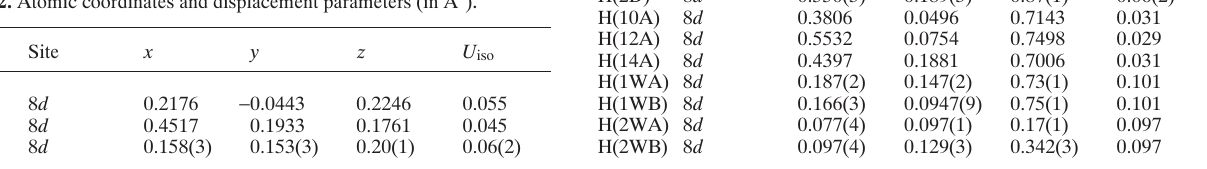
Table 2. Atomic coordinates and displacement parameters (in Å 2 ) .